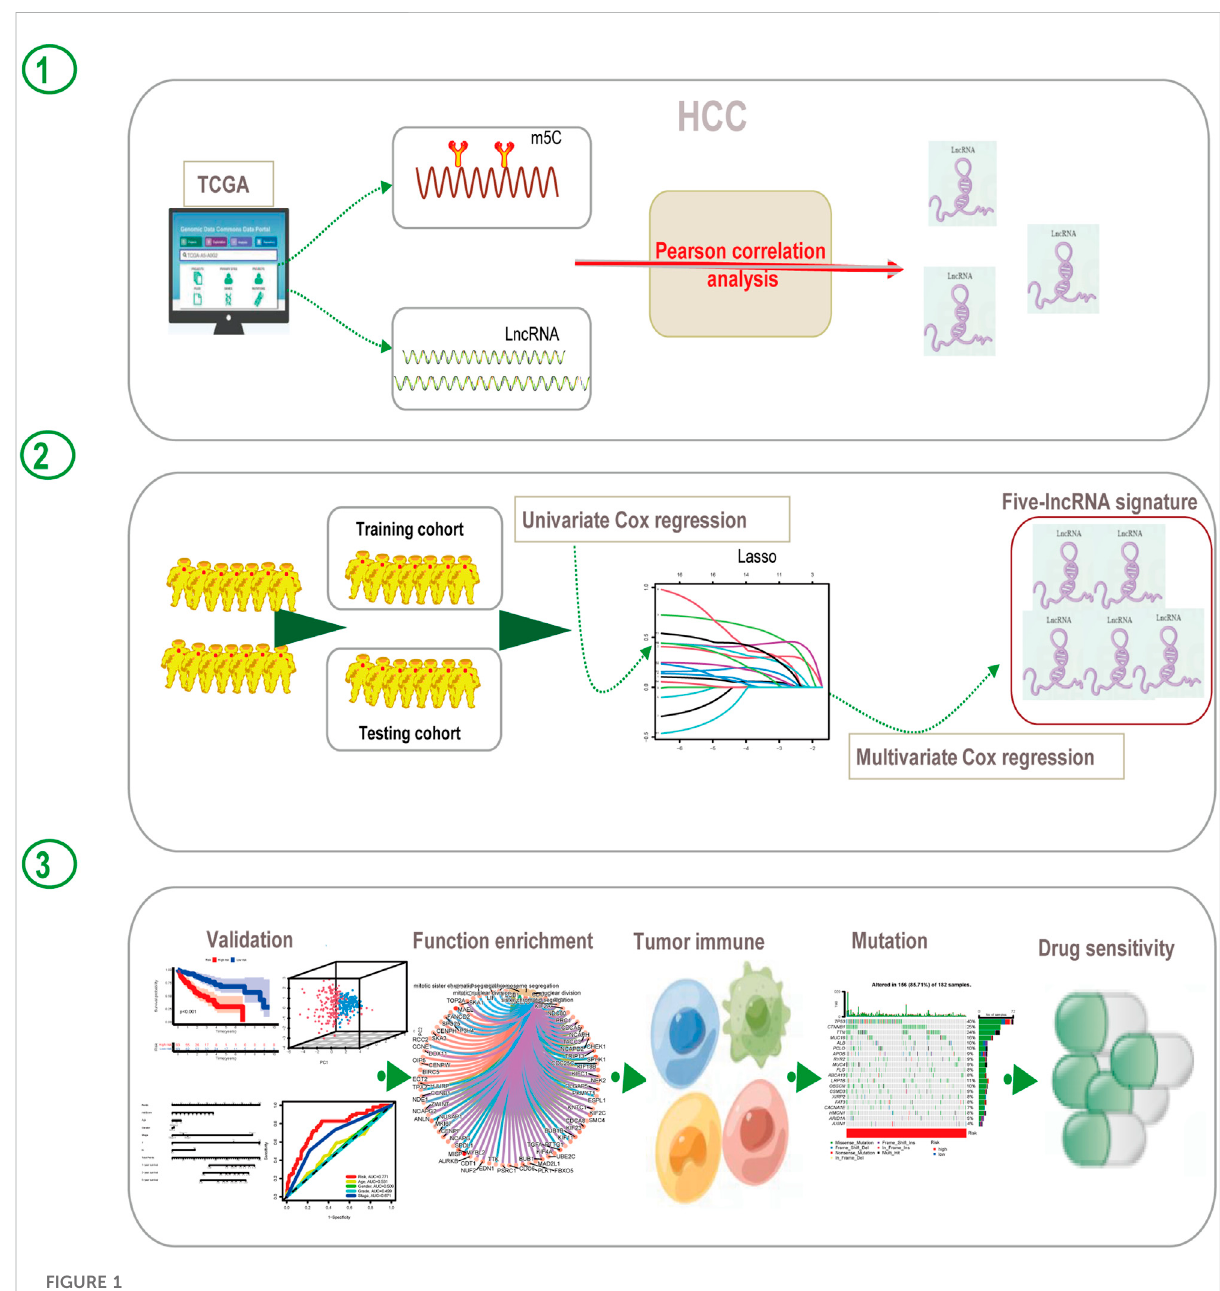
FIGURE 1 Flow diagram of this